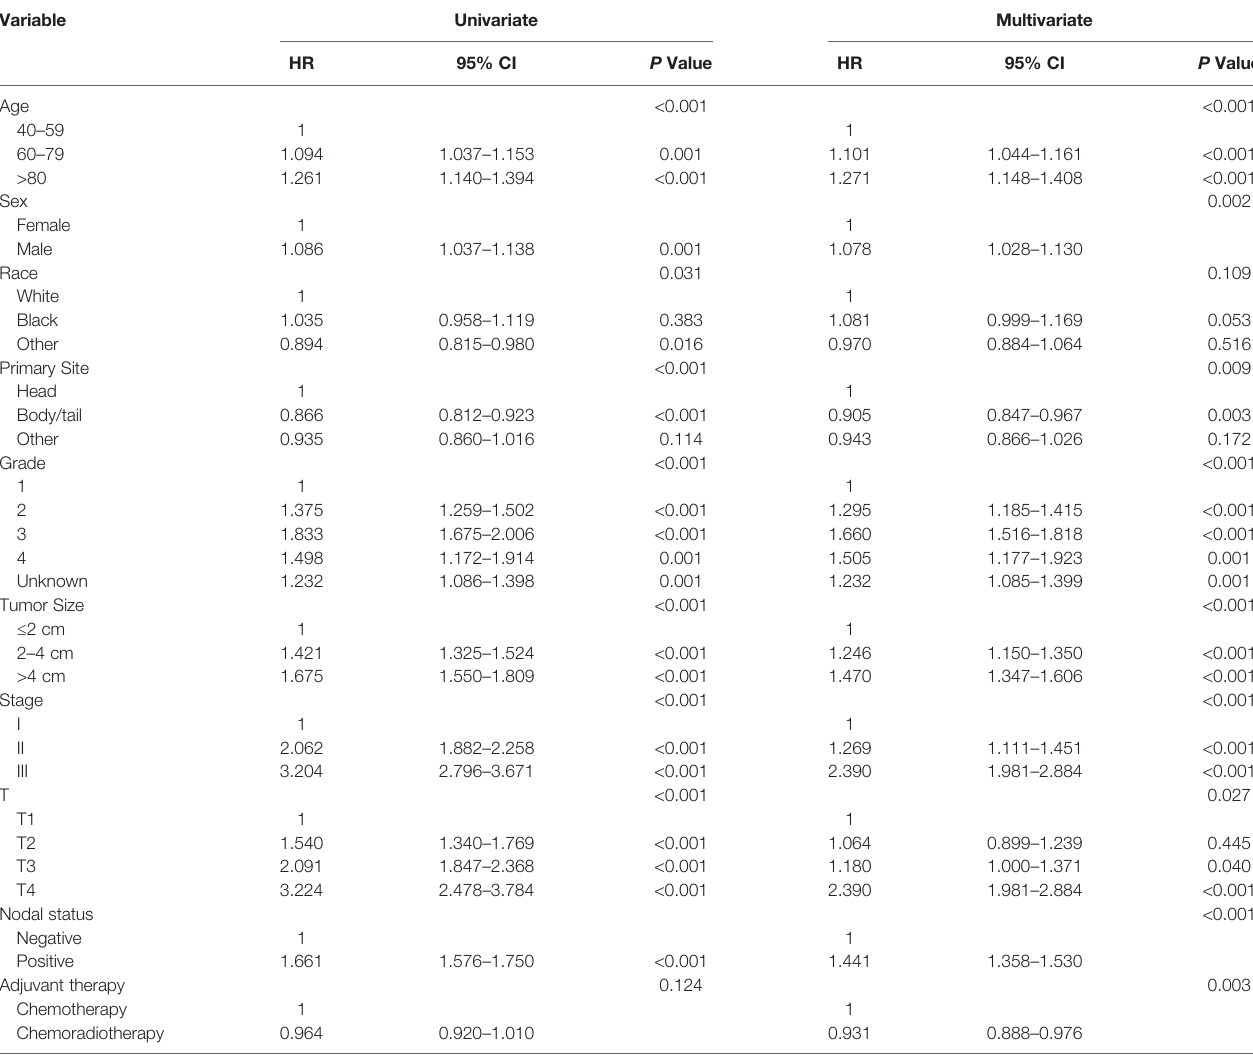
TABLE 2 | Univariate and multivariate analysis of overall survival rate.